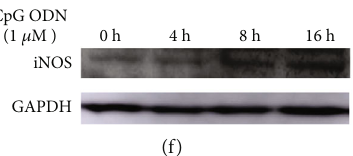
Figure 1: CpG ODN induced macrophage activation. (a) Representative phase-contrast images of RAW264.7 cells stimulated with CpG ODN1826 (1 μ M) for 0 h, 4h, 8h, and 16 h. (b, c) The RAW264.7 cells were treated with CpG ODN1826 (1 μ M) for 16h. And then, the mRNA and protein expression levels of TNF- α , IL-1 β , and IL-8 were determined by qRT-PCR (b) and ELISA (c). (d) In fl ammation- related gene expression levels were altered in the process of CpG ODN1826-induced macrophage activation from 0h to 16h. (e) Nitrite was determined in the supernatant of RAW264.7 cells stimulated with CpG ODN1826 for 16 h. (f) iNOS protein levels were detected by Western blot in RAW264.7 cells after stimulation with CpG ODN1826 for 16 h. ∗ p < 0 : 05